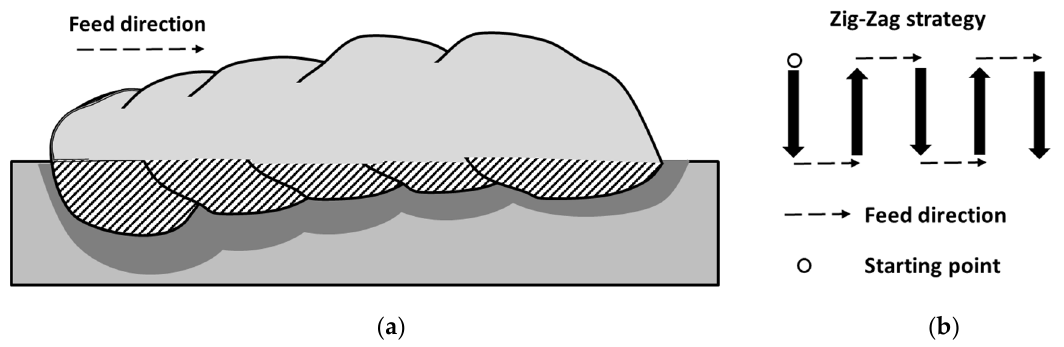
Figure 2. Overlapped clad deposited with the zig-zag strategy: ( a ) scheme of the final cross section of the coating; ( b ) scheme of the zig-zag strategy.